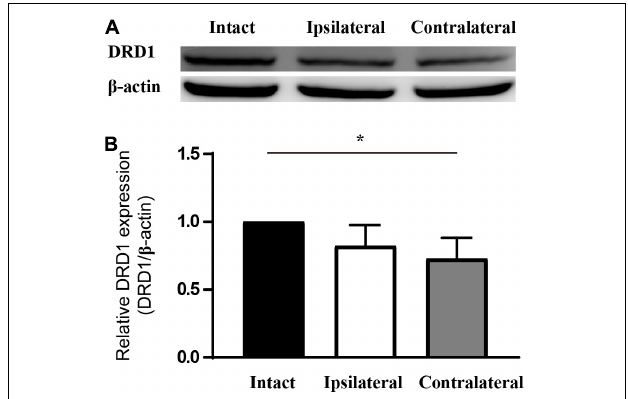
FIGURE 4 | DRD1 is downregulated in the LGN of monocularly deprived amblyopic mice. (A) Western blot of samples from mouse LGN. (B) Statistics of the relative expression level of DRD1. Set the value of intact LGN as 1. Data represent the mean ± SE. n = 3, * p <